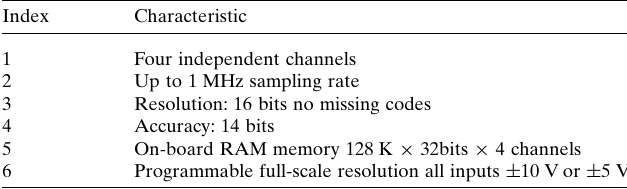
Table 2 Main characteristics of the